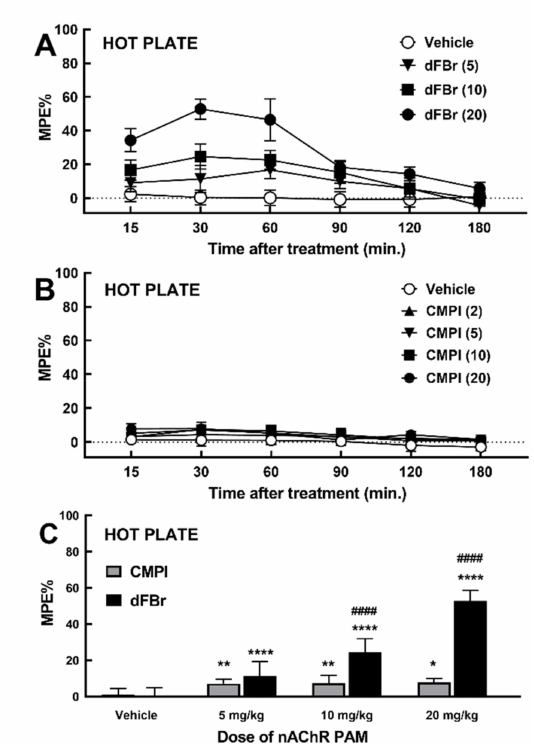
Figure 2. ( A , B ) Time course of the e ff ects of dFBr and CMPI, respectively, on acute thermal nociception in the hot plate test. Rats received i.p. injection of vehicle or increasing dose (in mg / kg) of dFBr or CMPI, then subjected to the hot plate at the time indicated. Data are shown as mean % MPE ± SD of at least six rats per each treatment group, as detailed under Materials and Methods (Section 4.3.1). ( C ) Peak dFBr and CMPI e ff ect at 30 min post-injection were analyzed using two-way ANOVA with Holm–Sidak’s multiple comparisons test. * p < 0.05, ** p < 0.01, *** p < 0.001, **** p < 0.0001 indicates statistical significance between drug treatment versus vehicle group. #### p < 0.0001 indicates the significant di ff erence between dFBr treatment versus treatment with the same dose of